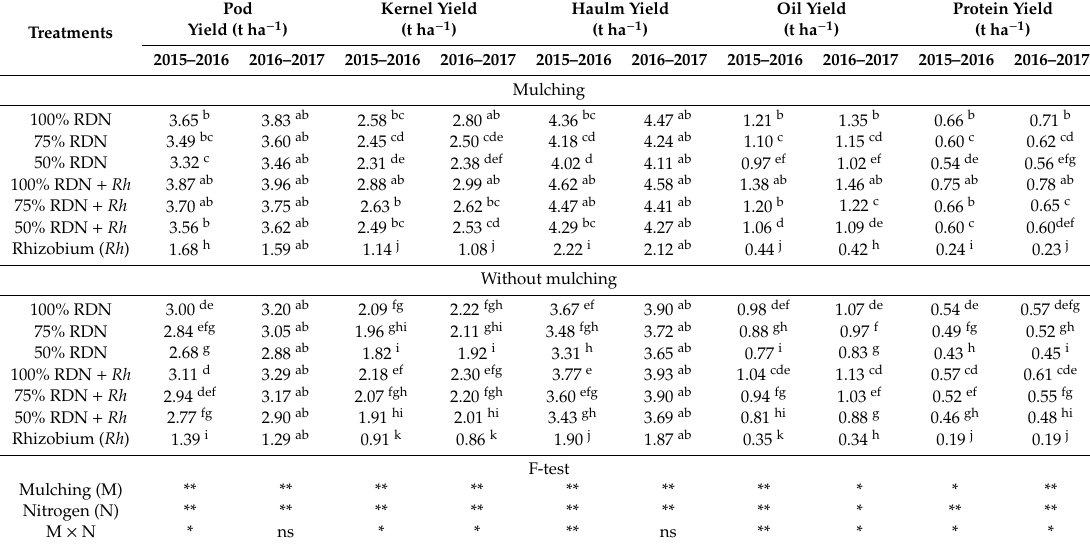
Table 3. Yield and quality of peanut under di ff erent mulching and nutrient management practices.